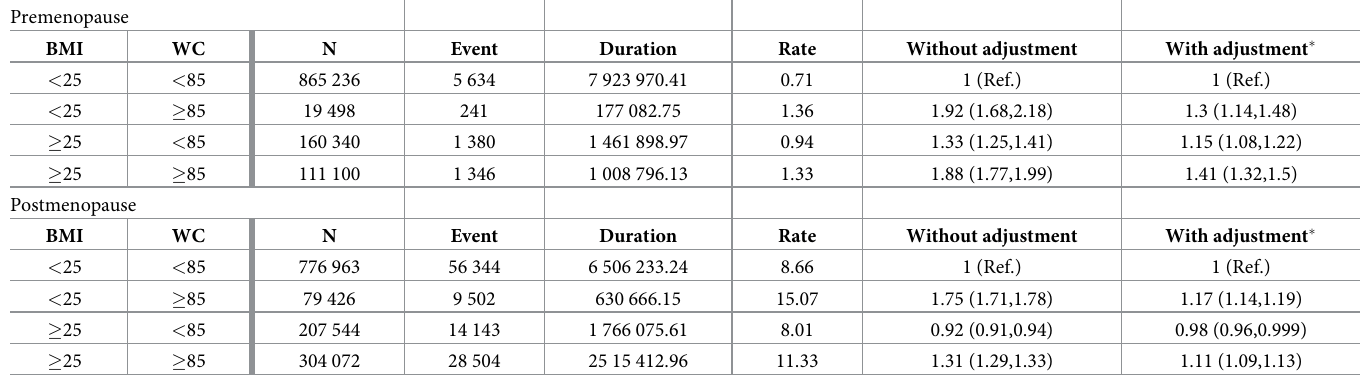
Table 8. Composite study on obesity and abdominal obesity according to BMI and WC using Cox proportional hazards regression analysis for the development of vertebral fracture in the premenopausal and postmenopausal groups.